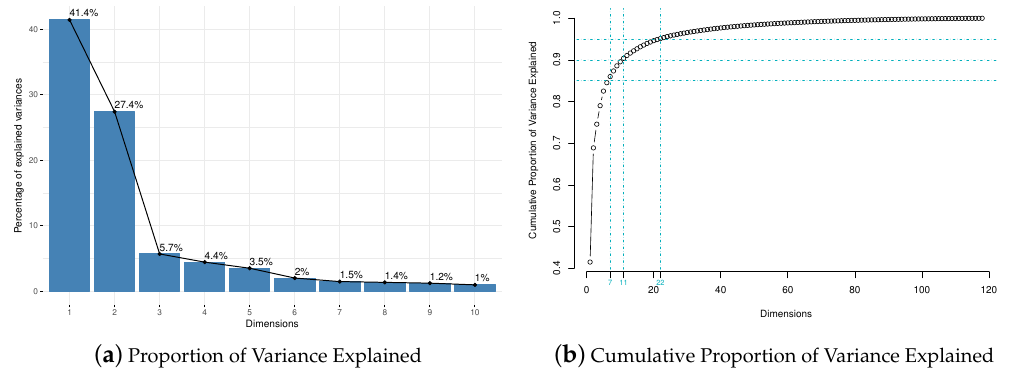
( b ) Cumulative Proportion of Variance Explained Figure 4. Illustration of difficult-to-determine parameters. Heuristically choose L